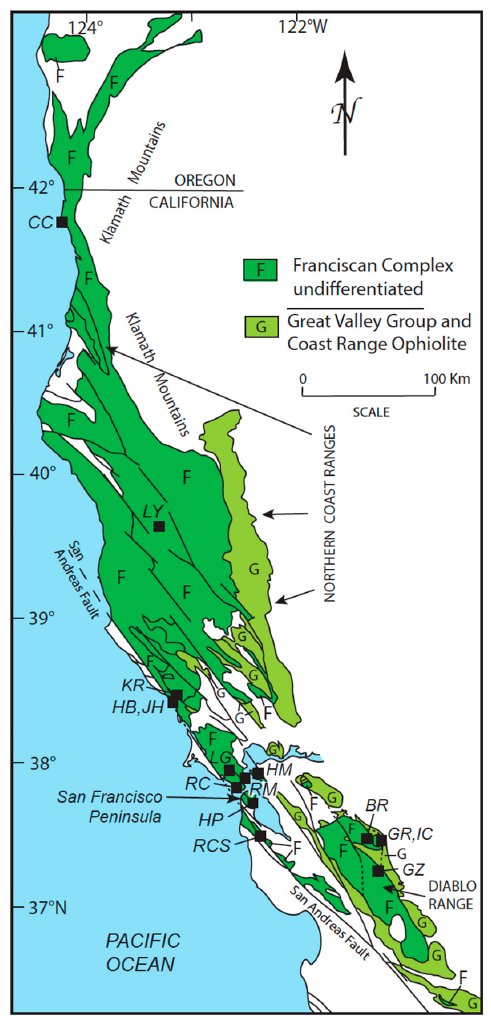
Figure 1. Generalized map of the Franciscan Complex of Oregon and the Northern Coast Ranges and Diablo Range of California, showing the general distribution of Franciscan rocks and the locations of exposures of mélanges described in the text. From north to south the mélanges are CC = Crescent City Olistostrome, LY = Laytonville Mélange, KR = King Ridge Road Mélange, HB = Heavens Beach Mélange, JH = Jenner Headlands Mélange, LG = Liberty Gulch Mélange, HM = Hillside Mélange of El Cerrito, RC = Rodeo Cove Mélange, RM = Ring Mountain Mélange, HP = Hunters Point Mélange, RCS = the Serpentinite Mélange of Redwood City, BR = Blue Rock Springs Mélange, GR = Gerber Ranch Mélange, IC = Ingram Creek Mélange, and GZ = the Garzas Mélange.